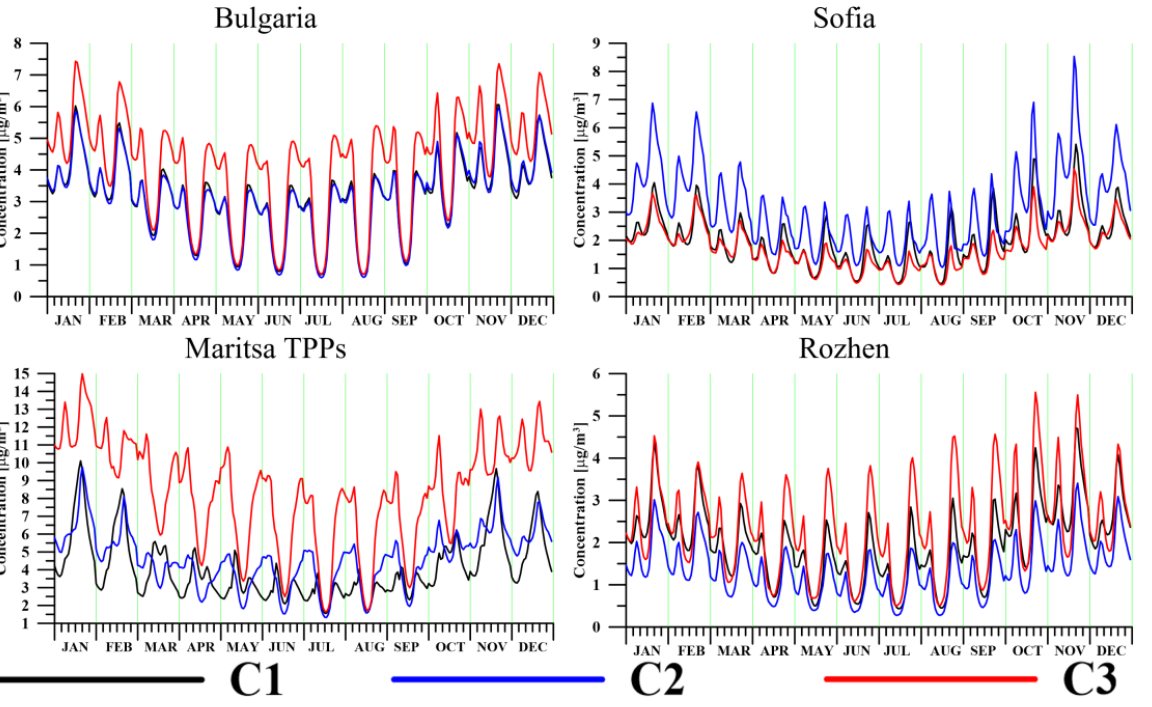
Figure 7. Diurnal and seasonal course of averaged over the ensemble surface concentrations of NO 2 [µg/m 3 ] for cases C1, C2 and C3.